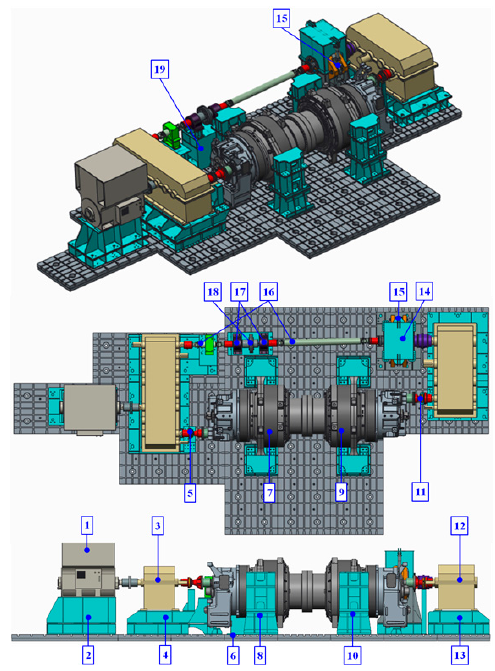
Figure A1. 3D model view of the developed test rig.